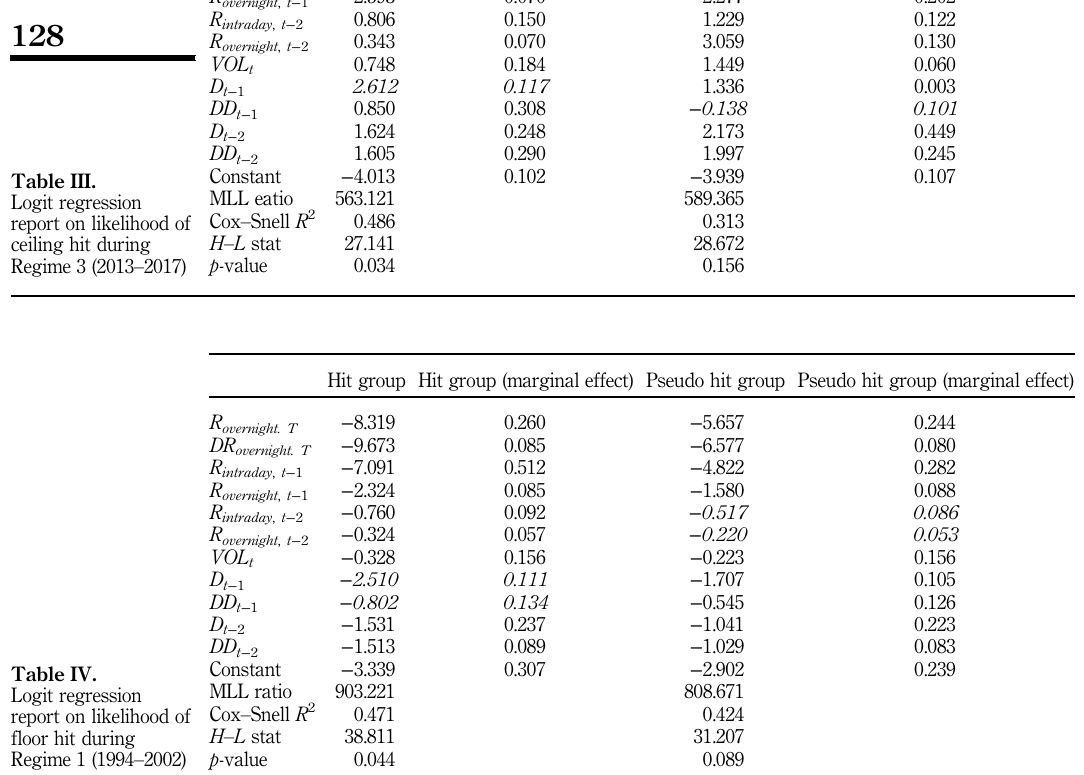
Table IV. Logit regression report on likelihood of floor hit during Regime 1 (1994 –